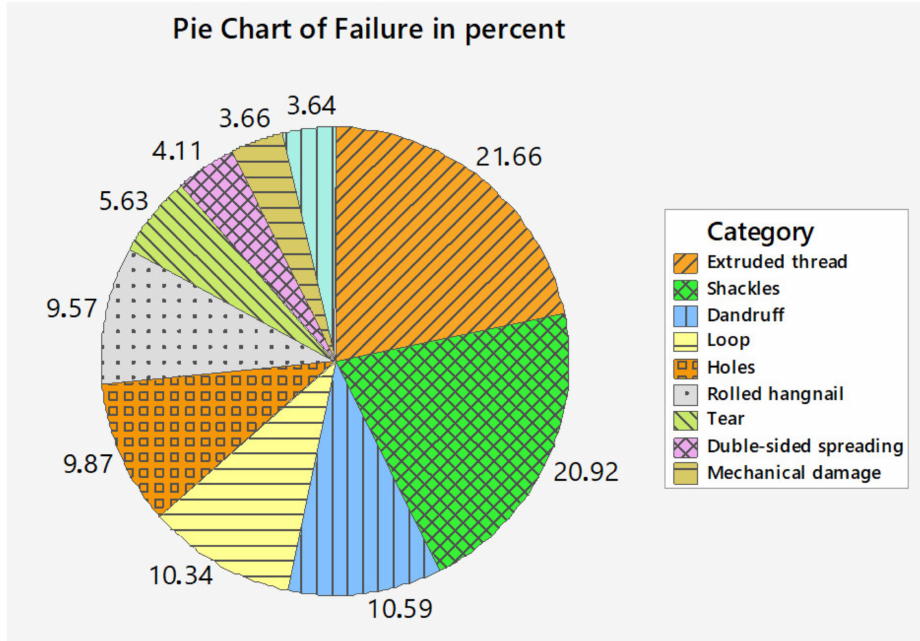
Figure 9. Occurrence of errors after measures. Source: own